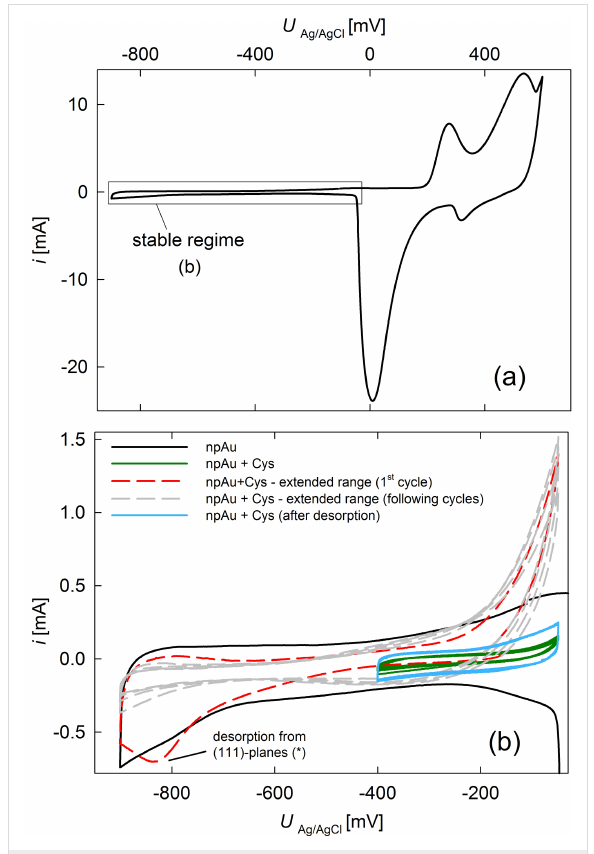
Figure 2: Cyclic voltammetry of sample A. (a) Measurement of the cysteine-free npAu between 600 and − 900 mV, (b) CVs recorded after modification with cysteine together with a part of the curve from (a) for reference. In (b), the double layer CV (solid curves) were recorded be- tween − 50 and − 400 mV and the electrochemical desorption (dashed curves) between − 50 and − 900 mV. (*)The peak was correlated to the desorption from the (111) plane based on [15]. The blue solid curve was recorded after the dashed curves. All CVs were conducted in 1 M KOH at a scan rate of 1 mV/s. Please note the change in x -axis scale between (a) and